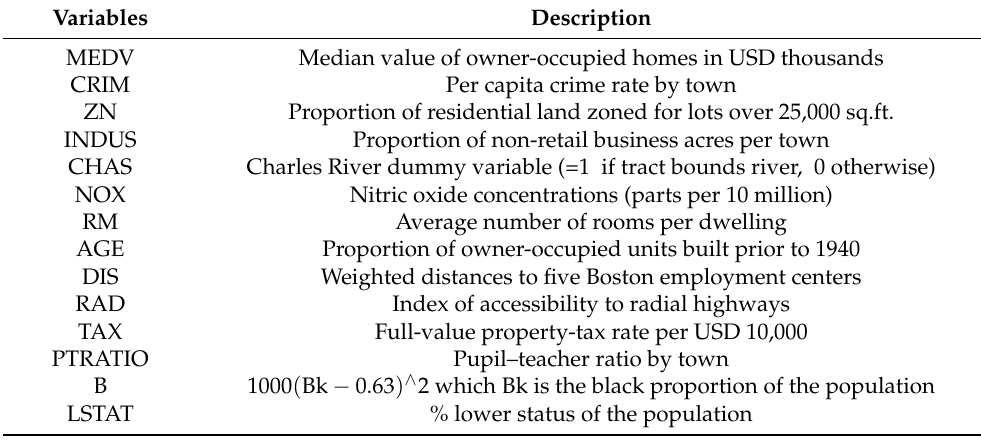
Table 3. Description of variables for Boston housing data.